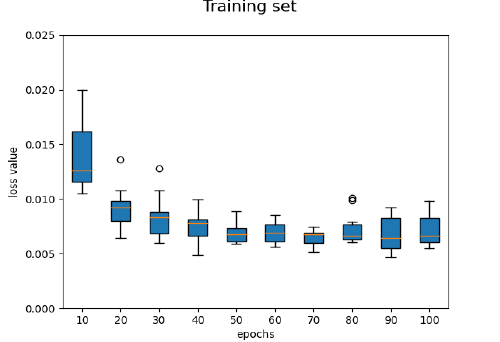
Figure 9. Training loss of moiré network.